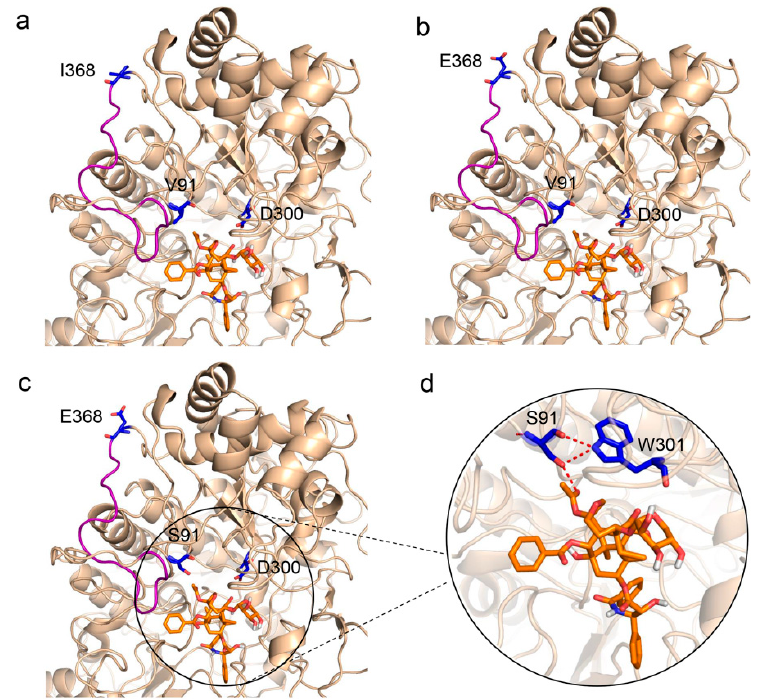
Figure 3. Partial view of enzyme-XDT docking. ( a ) Side view of LXYL-P1 − 1 with XDT, showing Val 91 and Ile 368 . ( b ) Side view of LXYL-P1 − 1 I368E with XDT, in which Ile 368 are replaced by Glu 368 . ( c ) Side view of LXYL-P1 − 1 V91S/I368E with XDT, in which Val 91 and Ile 368 are replaced by Ser 91 and Glu 368 , respectively. ( d ) Enlarged view of molecular docking of LXYL-P1 − 1 V91S/I368E with XDT, in which the increased hydrogen bonds among Ser 91 , Trp 301 , and XDT are indicated in red. The geometrical alteration of the loop near the active pocket is indicated in salmon. The carbon atoms of XDT are shown in orange. The nucleophile Asp 300 (catalytic site), Val 91 /Ser 91 and Ile 368 /Glu 368 are colored in